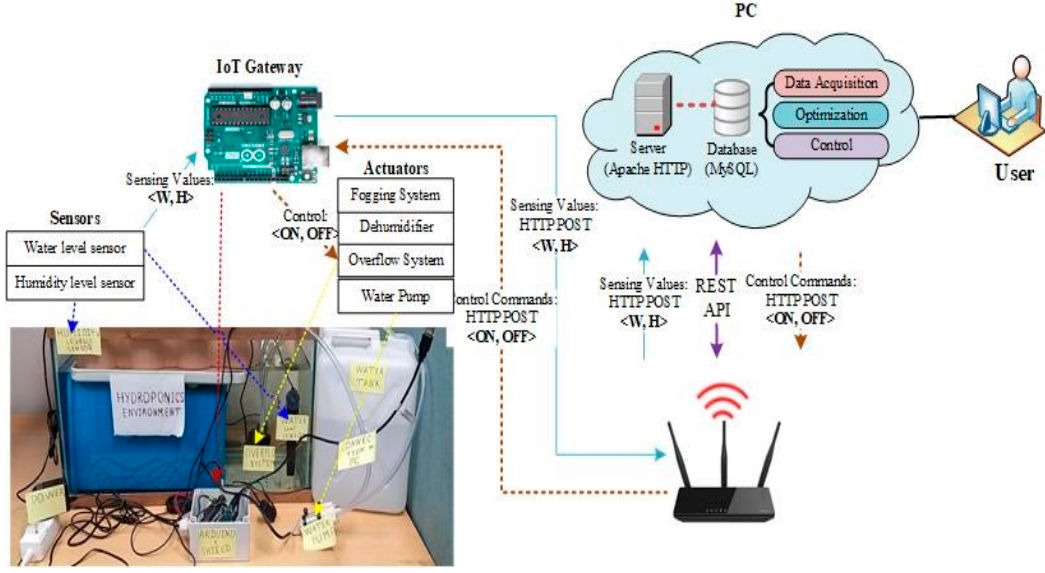
Figure 9. Data acquisition process.